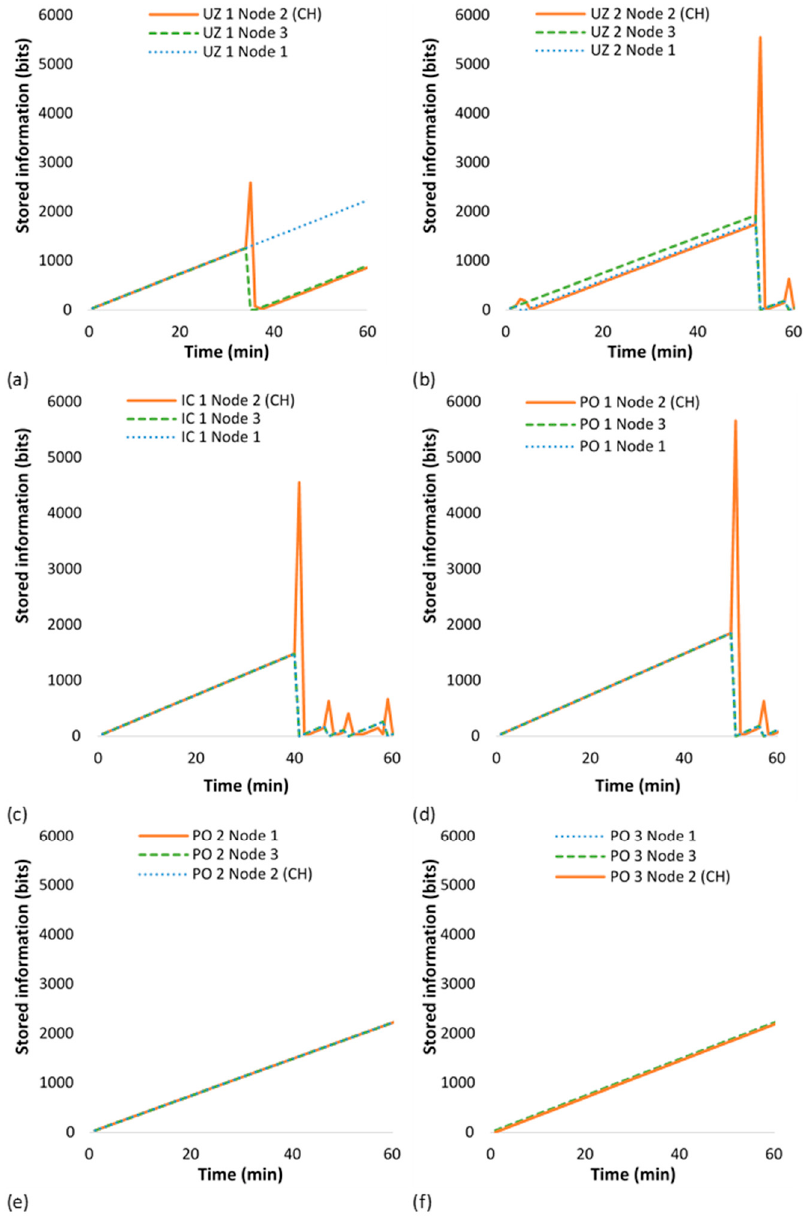
Figure 10. Stored information in the SDs cards of nodes. Details of the first 60 min of operation. Different letters ( a ) to ( f ) denote the different locations of the cluster: ( a ) UA1, ( b ) UA2, ( c ) IC1, ( d ) PO1, ( e ) PO2, and ( f ) PO 3.